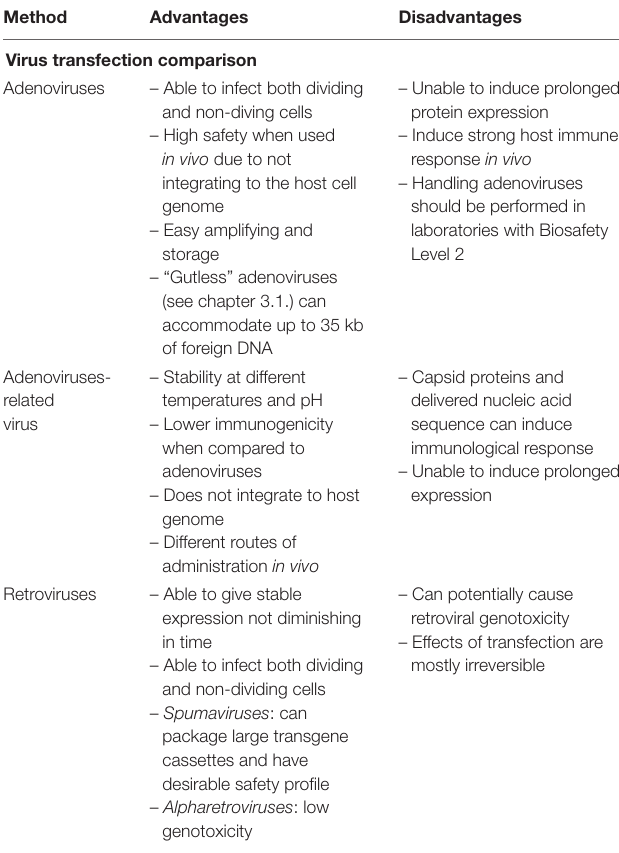
TABLE 2 | The differences between the different viral vectors.